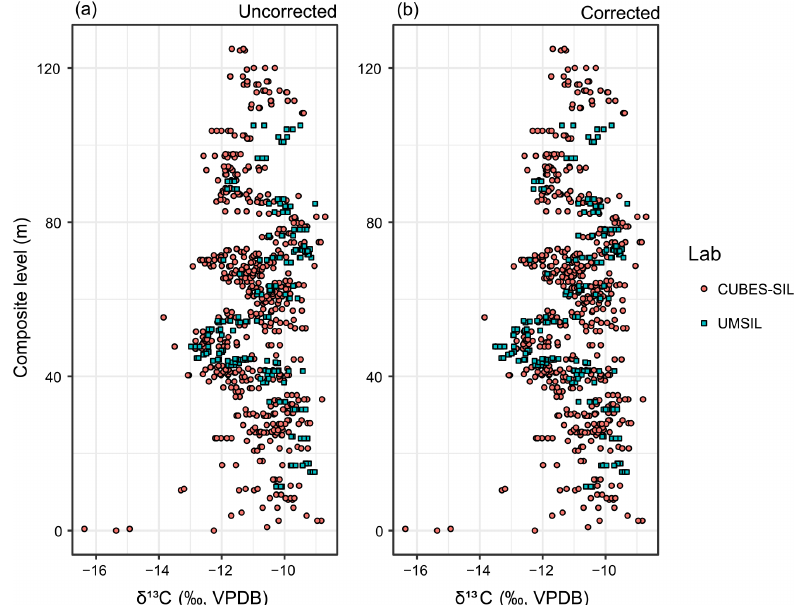
Figure C3. Pedogenic carbonate δ 13 C showing samples that were analyzed in the UMSIL lab uncorrected (a) and corrected (b) using the carbon regression equation from Fig. B2. Points represent individual sample measurements. The corrected UMSIL values (b) are used throughout the text. This composite section includes the Basin Draw and D-1454 sections, with the top of the Basin Draw section correlated with the lowest CIE